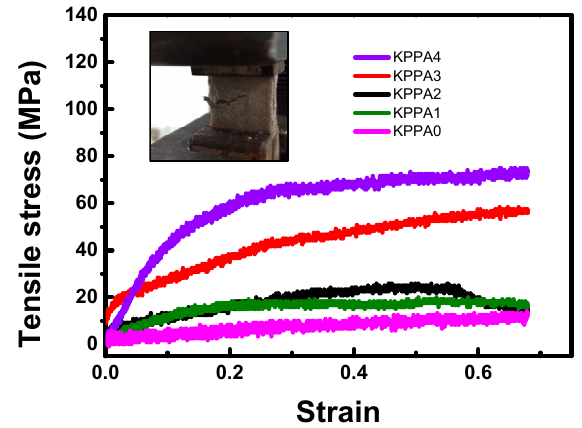
Figure 9. Tensile stress of the KPPA0, KPPA1, KPPA2, KPPA3 and KPPA4 cryogels.